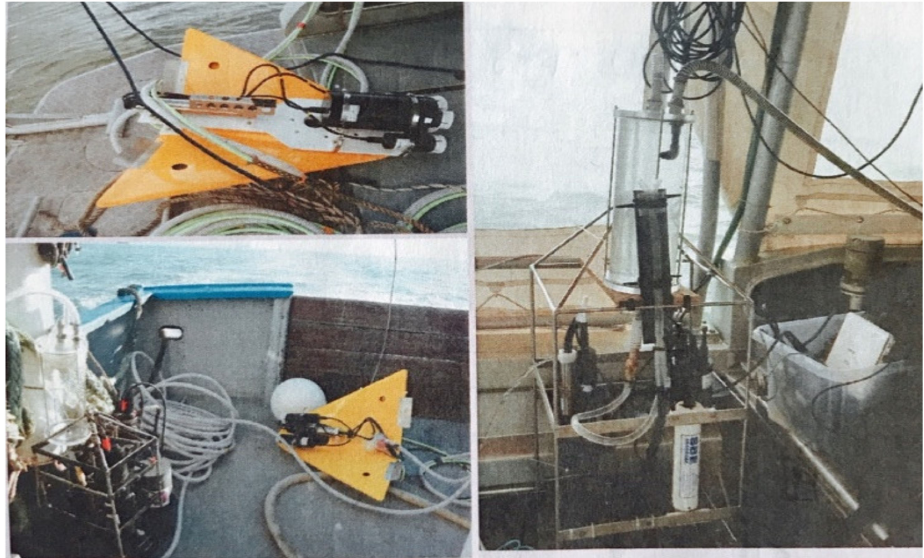
Figure 4. Bot-wing equipped with a CTD and optical sensor for high spatial lateral and depth measurements